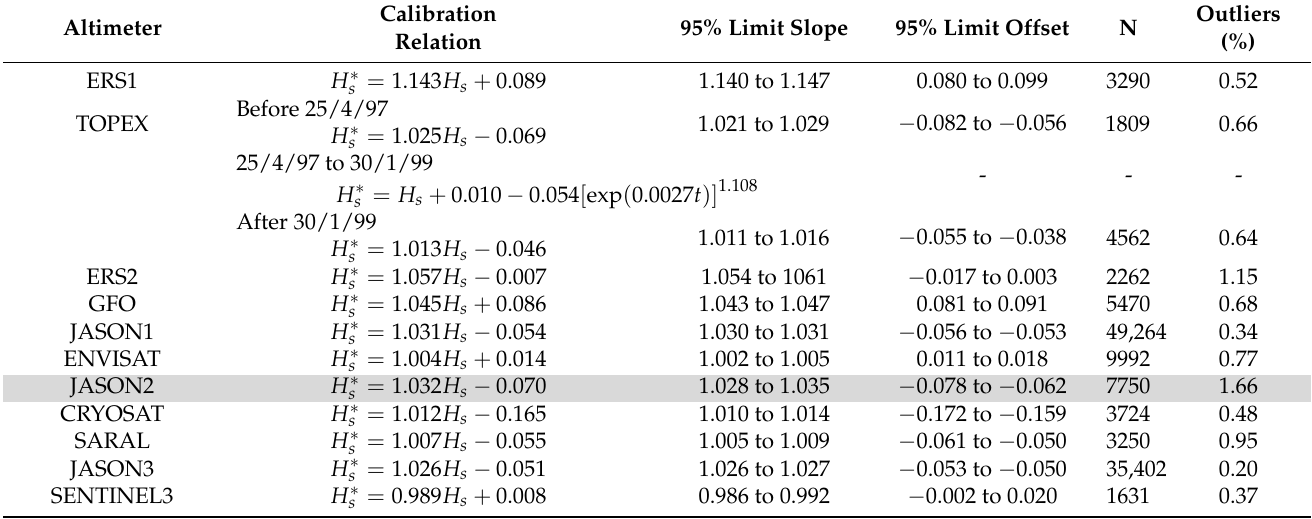
Table A1. “Altimeter–altimeter” calibration relationships. H ∗ s is the calibrated value and H s the uncalibrated value. 95% confidence limits on the slope and offset show in columns 3 and 4. Number of matchup points in the RMA regression shown in column 5. Percentage of outlier points shown in column 6. JASON2 is shaded as this calibration is against buoy data (the reference